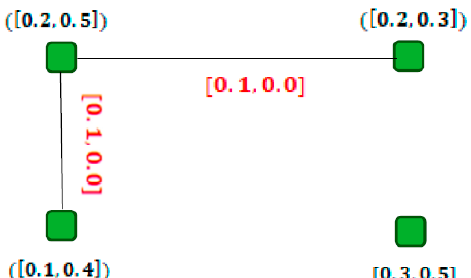
Figure 8. Interval-valued fuzzy graph.